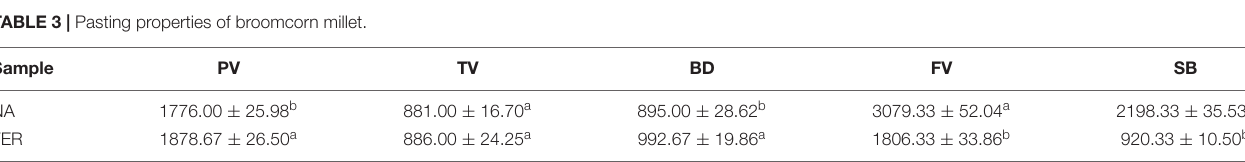
Means within a column followed by different letters are significantly different (P < 0.05).